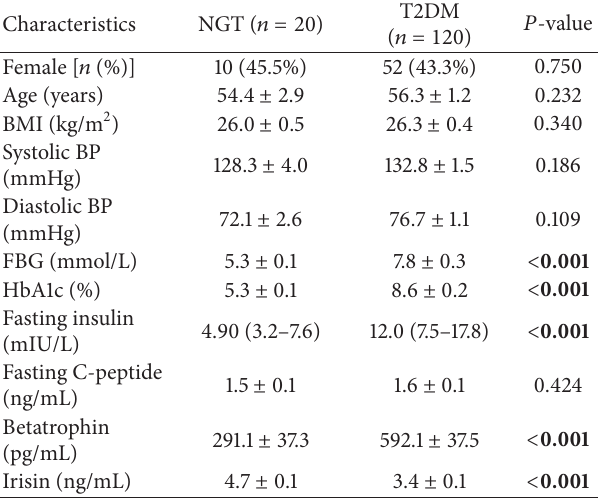
Table 1: Characteristics of NGT and T2DM